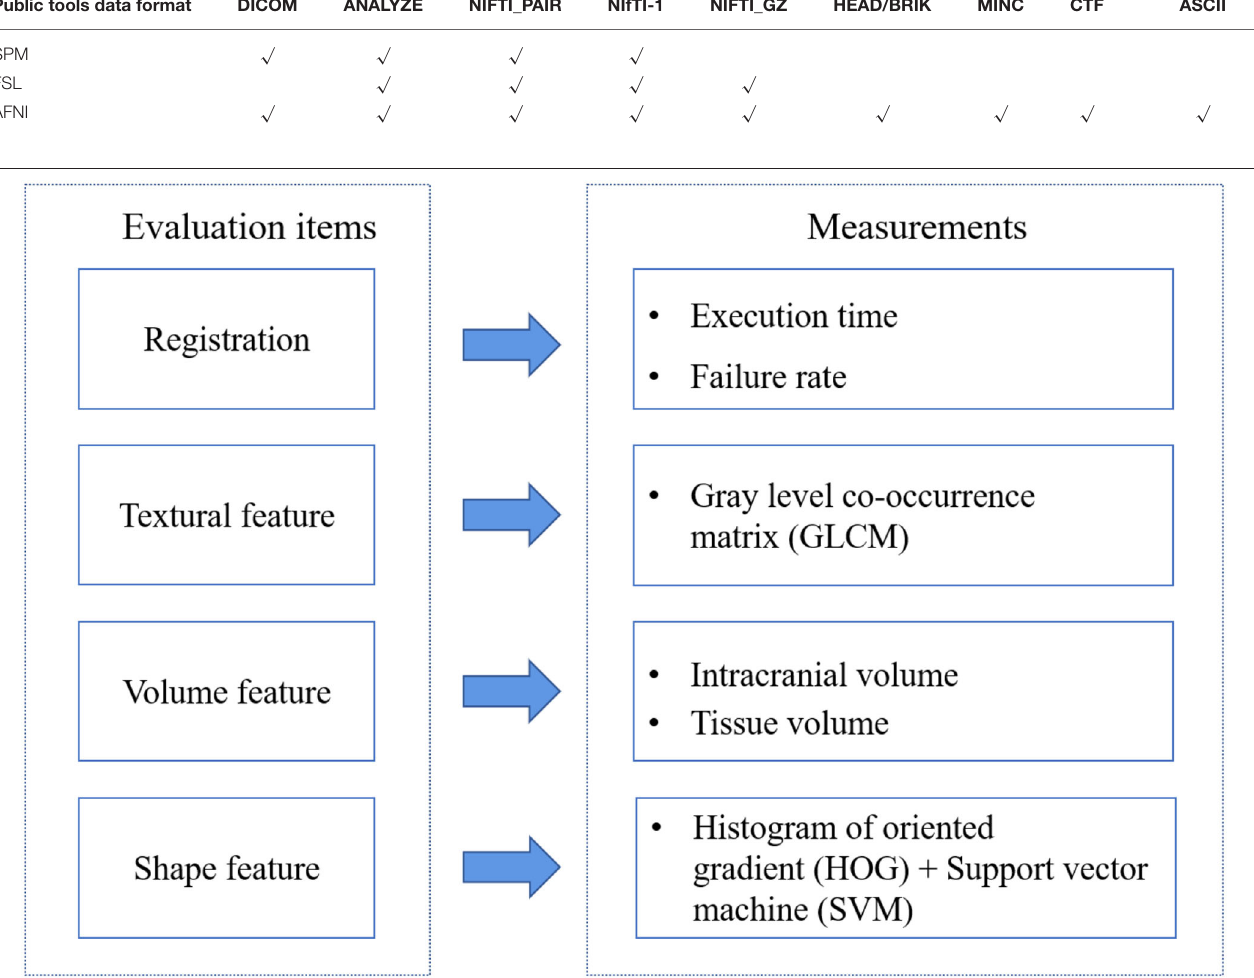
TABLE 2 | Format requirements.